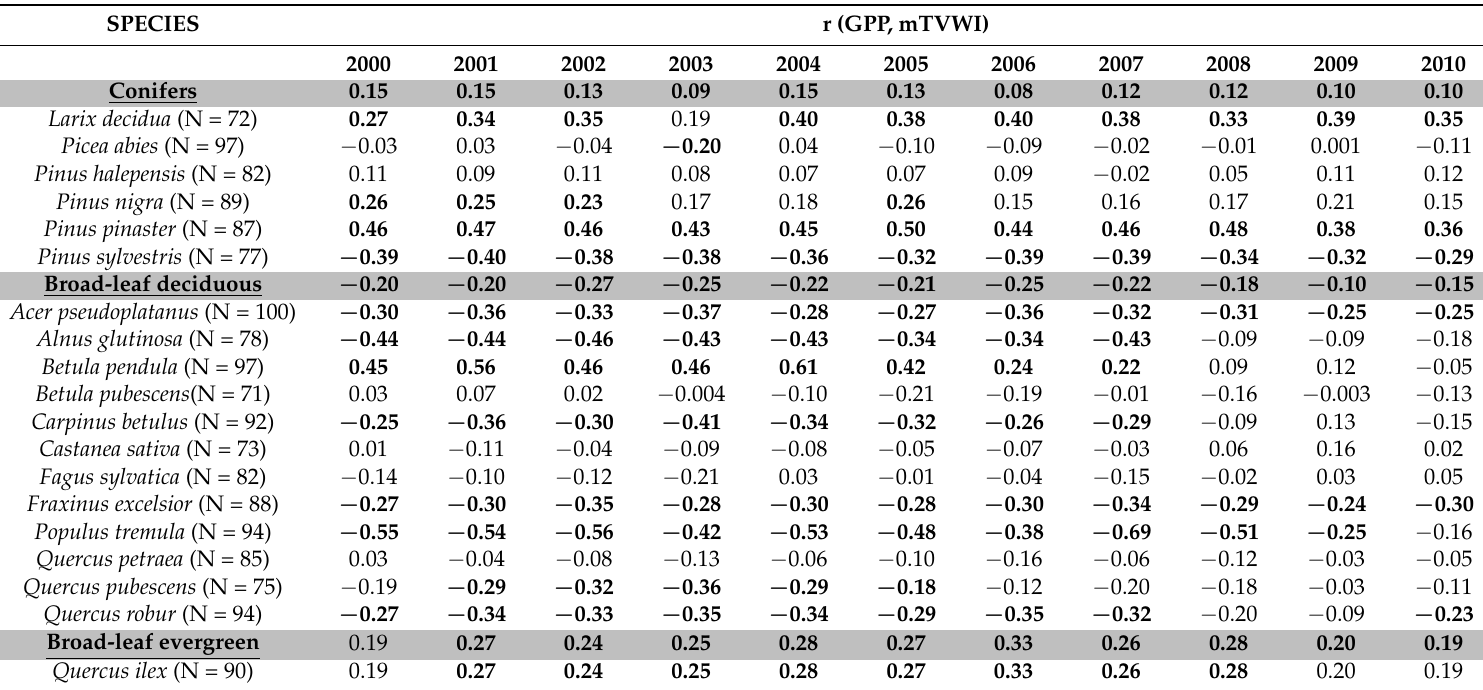
Table 1. Partial correlation coefficients (controlling for: temperature (T)) for the correlation between gross primary production (GPP) and the modified temperature vegetation wetness index (mTVWI). Bold indicates significance at p <